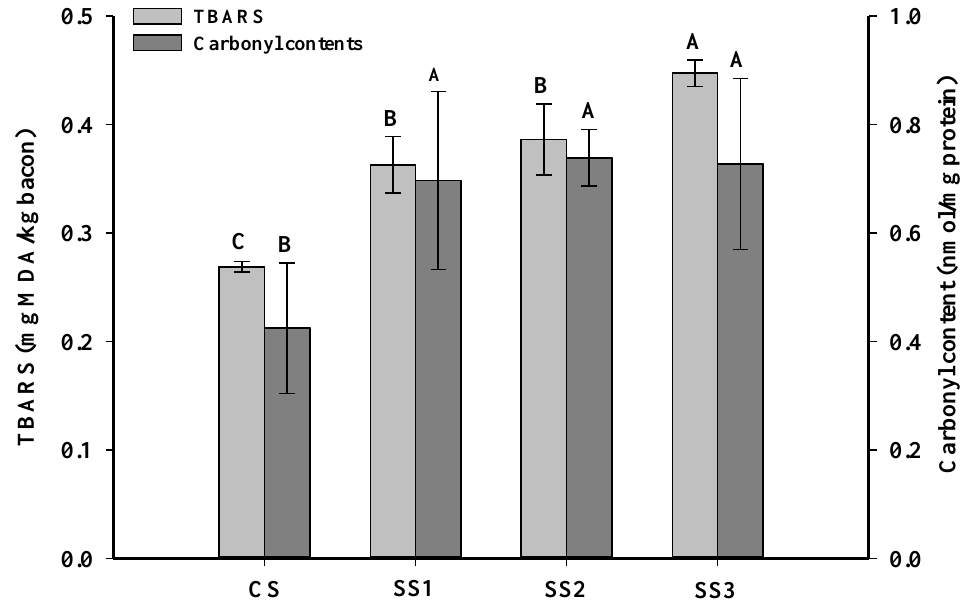
Figure 1. Influence of the partial replacement of NaCl by KCl on the TBARS and carbonyl contents of bacon. A–C Means in the TBARS or carbonyl contents within different KCl-substituting rates are significantly different ( p < 0.05). CS, control (100% NaCl); SS1, 90% NaCl + 10% KCl; SS2, 80% NaCl + 20% KCl; and SS3, 70% NaCl + 30% KCl. TBARS: thiobarbituric acid reactive substance.